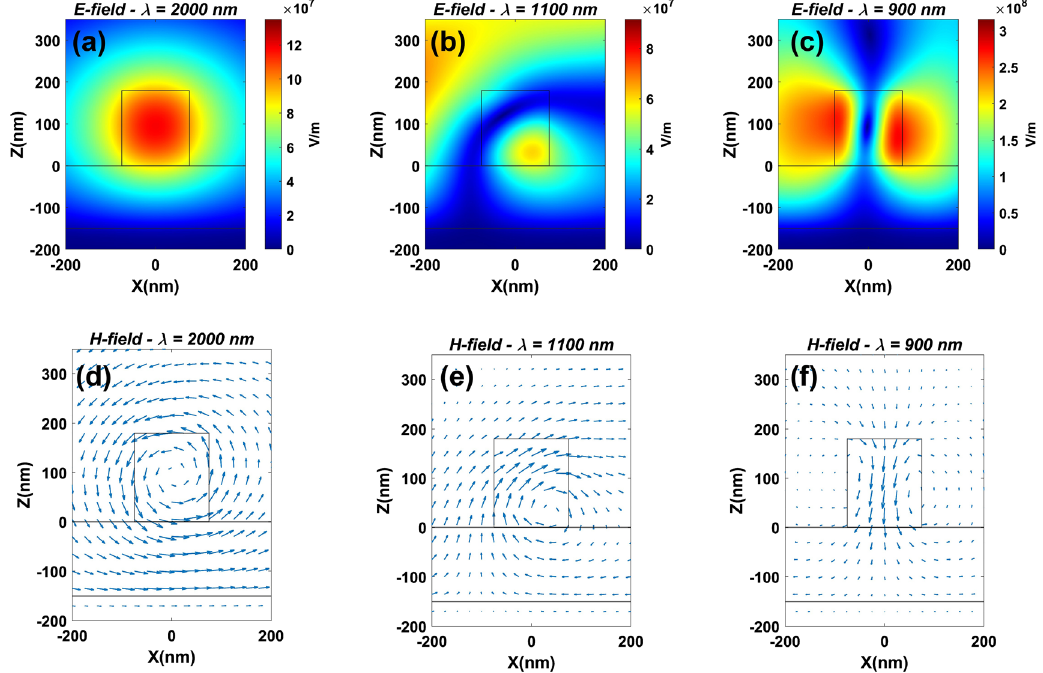
Figure 3: Contour maps of electric field (a – c) and quiver maps of magnetic field (d – f) inside and near a nanorod at (a, d) λ = 2000 nm, (b, e) λ = 1100 nm, and (c, f) λ = 900 nm; θ = 20 ° , TE